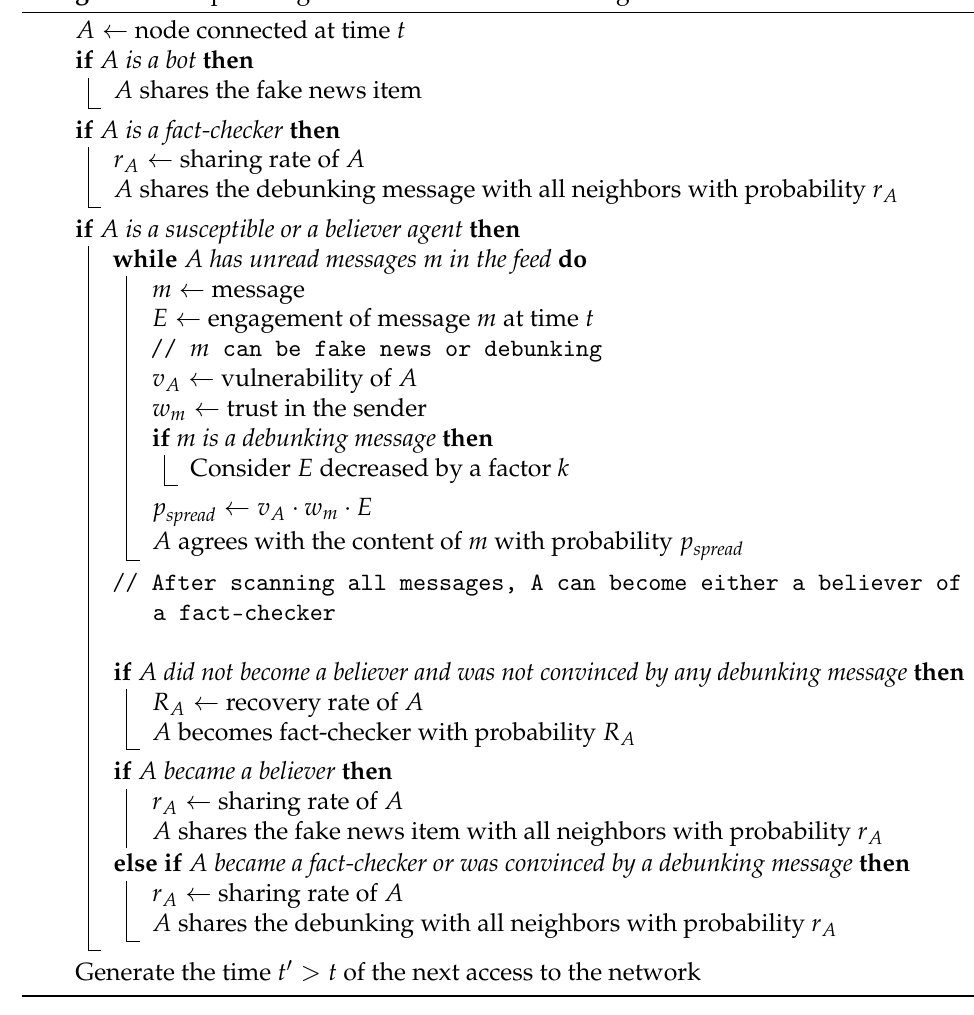
Algorithm 1: Spreading of fake news and